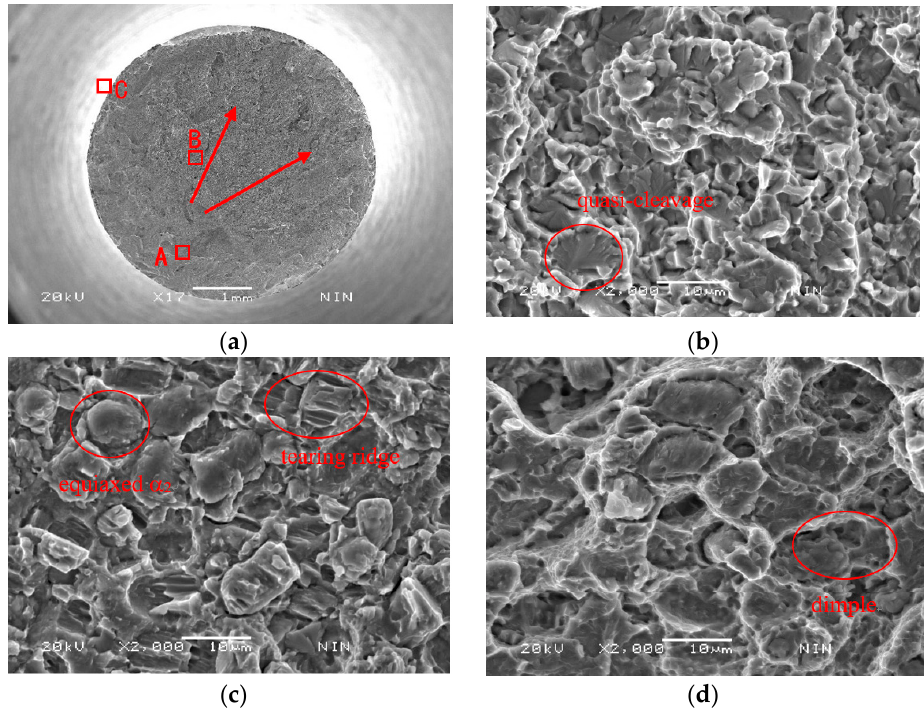
Figure 3. Room-temperature tensile fractographs of equiaxed-microstructure (the tensile samples were cut from the tangential direction of the circular billets which were formed through isothermally forging at α 2 + B2 + O phase regions), ( a ) macro-fractograph (area A is the fibrous zone, area B is the radiation area and area C is the shear lip); ( b ) the enlarged micro-fractograph of the red box in area A; ( c ) the enlarged micro-fractograph of the red box in area B; ( d ) the enlarged micro-fractograph of the red box in area C.